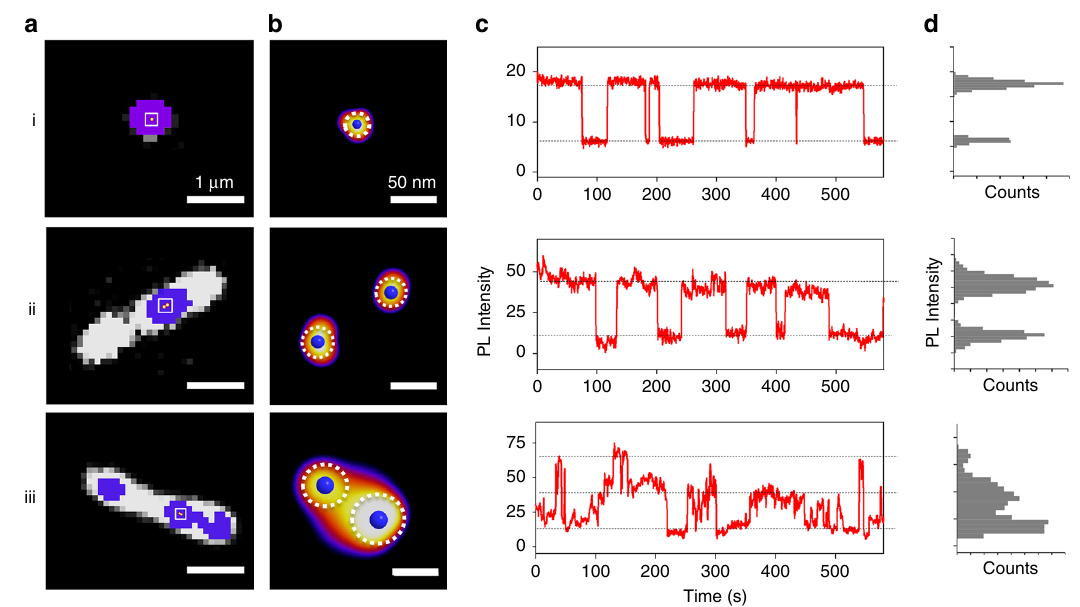
Fig. 3 Super-localization and PL blinking of individual 4-nitroaryl defects. Note that the images on the same row are associated with the same defect sites. a The diffraction-limited PL images of the defect emission sites (blue) and intrinsic E 11 exciton emission (white) reveal the localized nature of the defects along the nanotube length. b Individual defects within those emitting sites marked in ( a white square) are resolved with sub-pixel resolution. Here, individual defect localization is displayed as blue spots with the corresponding localization precision as dotted circles. c PL intensity trajectories (red solid line) from each defect emitting sites reveal stochastic blinking behavior and d the corresponding PL intensity histograms show bimodal (i) and (ii), and trimodal (iii) intensity states. Dashed lines are added as a guide to the